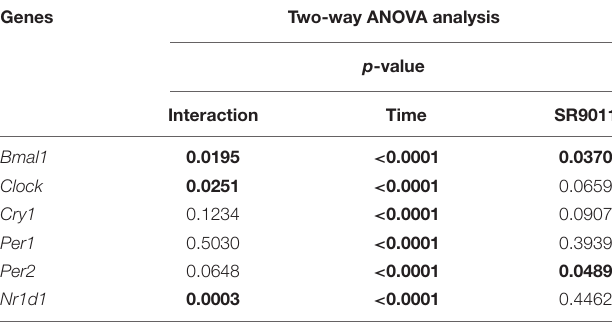
TABLE 1 | Two-way ANOVA assessment of effect of Time, SR9011, and Interaction in clock genes in primary microglia with